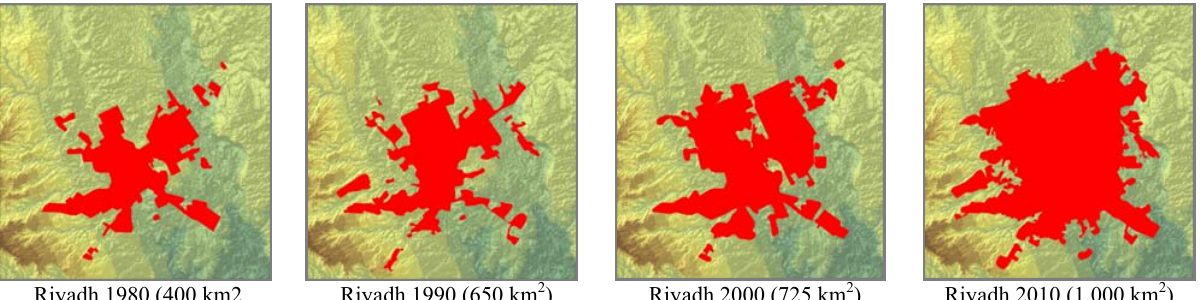
Figure 1: Development of Riyadh, the capital of KSA, between 1980 and 2010